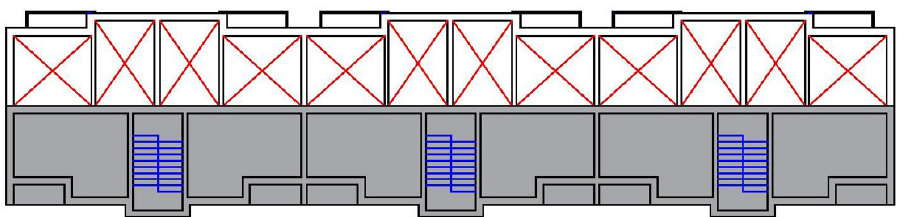
Figure 12. Retrofitting of an existing flexible floor structure by means of horizontal steel truss after Figure 12. Retro fi tt ing of an existing fl exible fl oor structure by means of horizontal steel truss after the 2010 Kraljevo, Serbia the 2010 Kraljevo, Serbia earthquake.